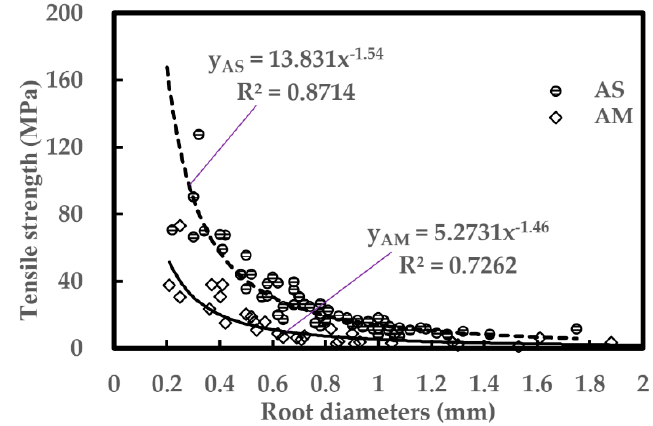
Figure 7. Root tensile strength vs. root diameters for the alpine swamp meadow (AS) and alpine meadow (AM).